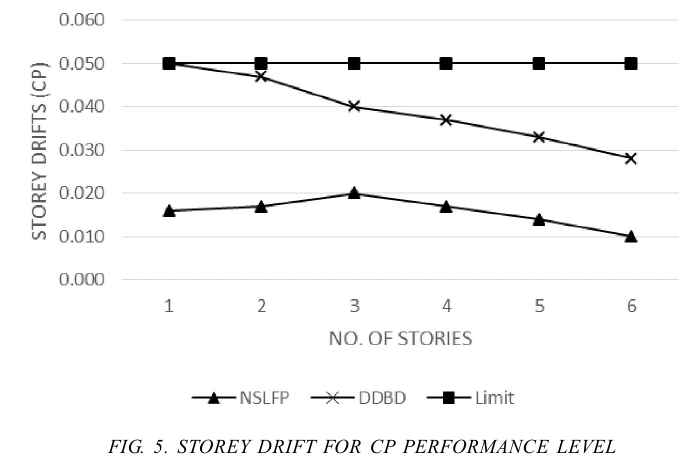
FIG. 5. STOREY DRIFT FOR CP PERFORMANCE